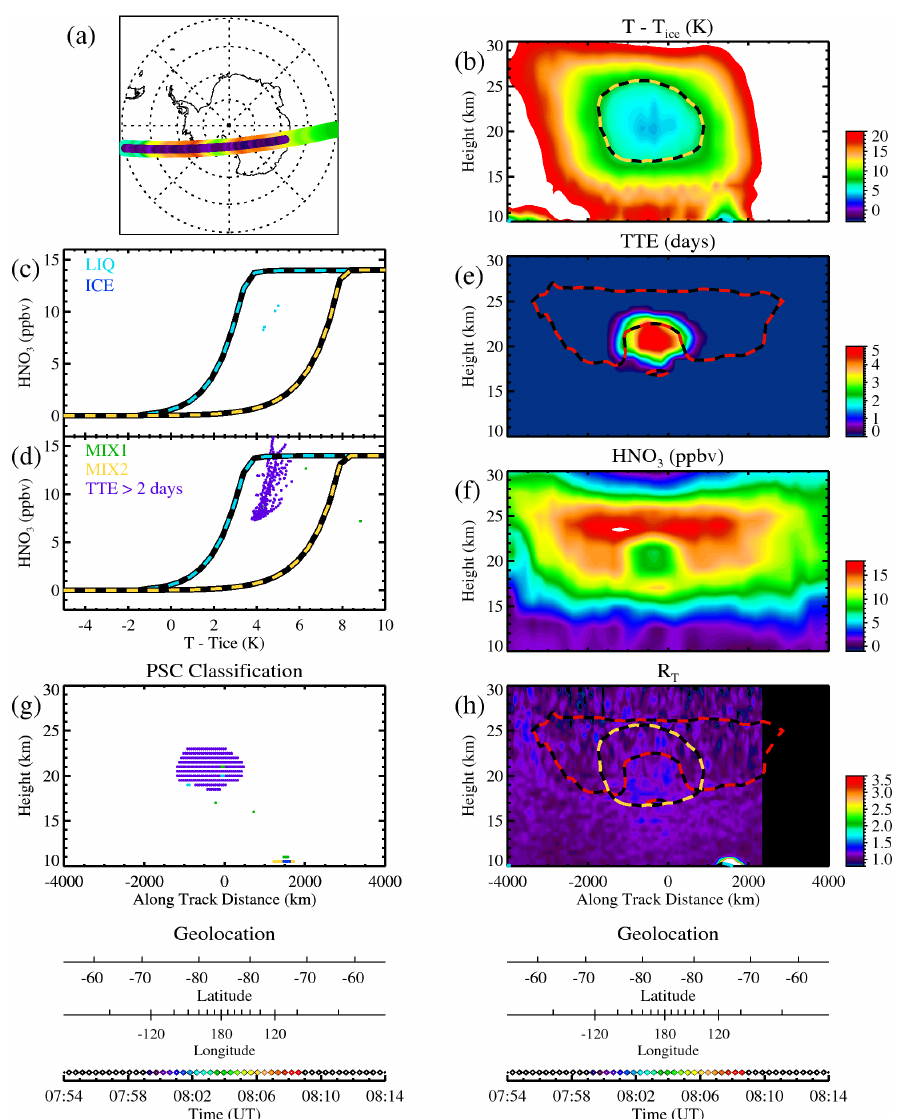
Fig. 7. (a) Geographic region sampled on an orbit track on 25 May 2008 through a denitrified region. The outer colored band represents the MLS HNO 3 values at 22km and the inner band represents the corresponding CALIOP backscatter ratio. The along-track distance is centred on the closest approach of the orbit track to the pole. (b) Temperature relative to the frost-point ( T − T ICE ). (c) Temperature distribution of MLS HNO 3 corresponding to the CALIOP identified LIQ (cyan) and ICE (blue) PSC types (d) as (c) except for MIX1 (green) and MIX2 (yellow) PSC types and additionally for TTE > 2 days (purple). (e) Temperature threshold exposure (TTE) in days. (f) MLS HNO 3 . (g) PSC type classification with additional background shading for TTE > 2 days (purple). (h) CALIOP total backscatter ratios. Cyan-black and yellow-black dashed lines in (c, d) indicate the equilibrium curves for STS and NAT, respectively. Red-black dashed contours indicate the 12ppbv HNO 3 isopleth and yellow-black dashed contours in (b, h) indicate the T NAT threshold temperature. All temperatures and temperature differences are given in